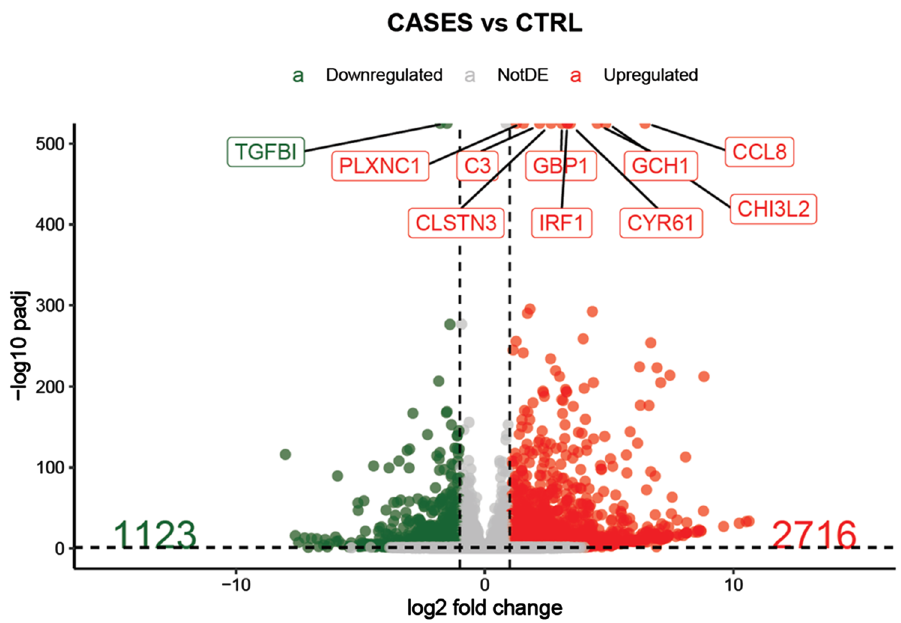
Figure 3. Volcano plot showing the effect size log2 fold-change (x axis) and significance (y axis) of each tested gene. Cut-off: log2FC ≥ 1 or log2FC ≤ − 1 and FDR <